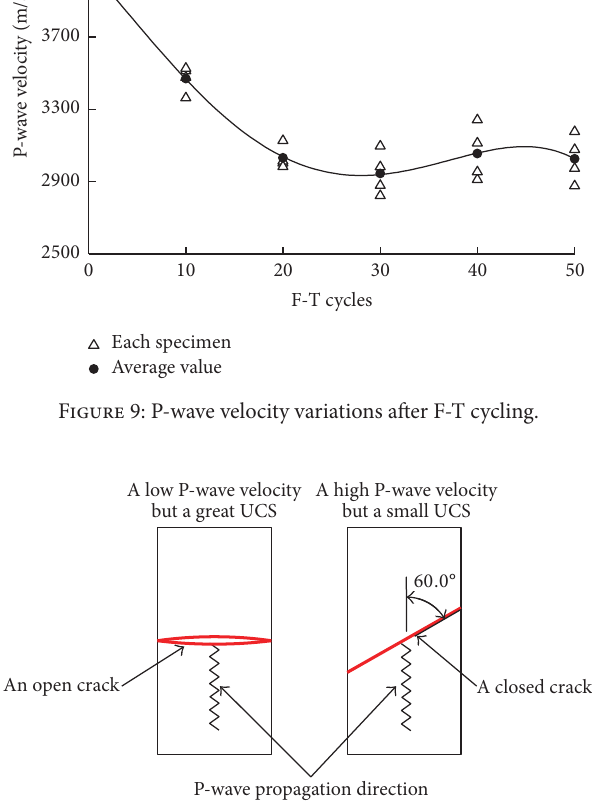
Figure 10: Unrelated correlation between the P-wave velocity and